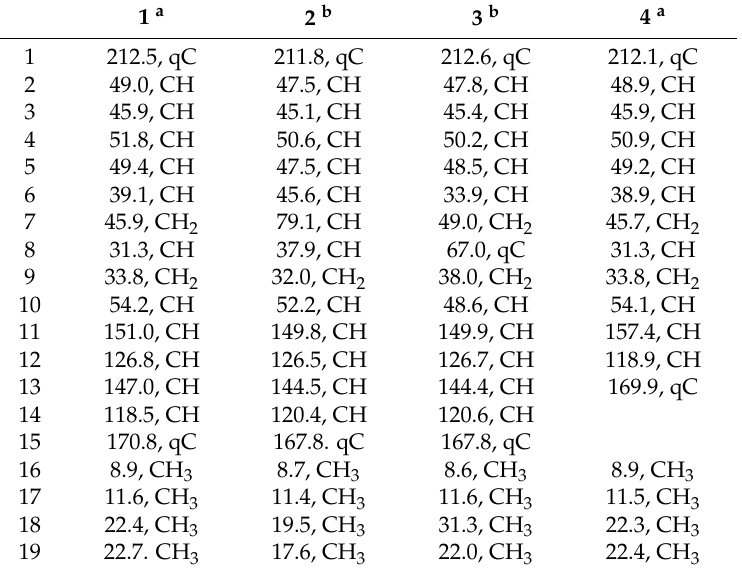
Table 1. 13 C chemical shifts (175 MHz for 1 , 2 , 4 ; 125 MHz for 3 ) of elsinopirins A–D ( 1 – 4